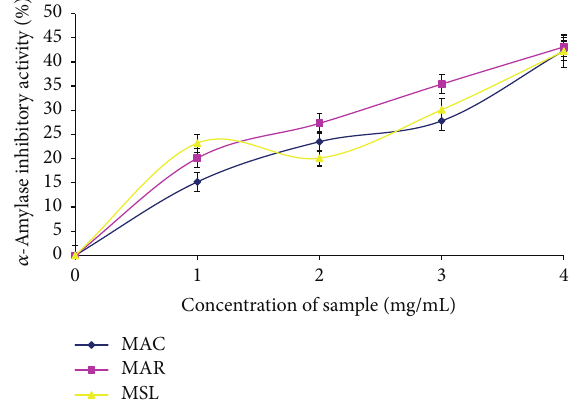
Figure 2: 𝛼 -Amylase inhibitory activity of Musa sapientum (Latun- dan banana) (MSL), Musa acuminata (Cavendish banana) (MAC), and Musa acuminate (Red Dacca) (MAR).